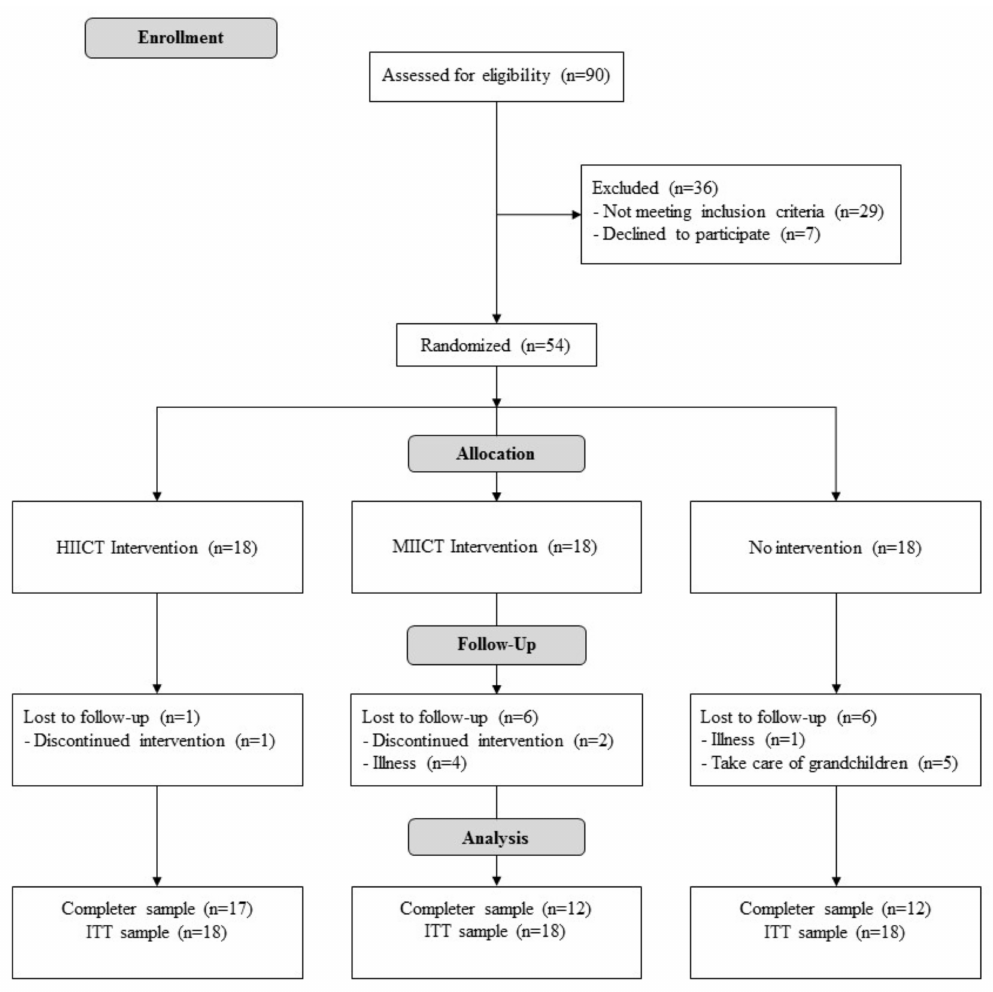
Figure 1. Study flow